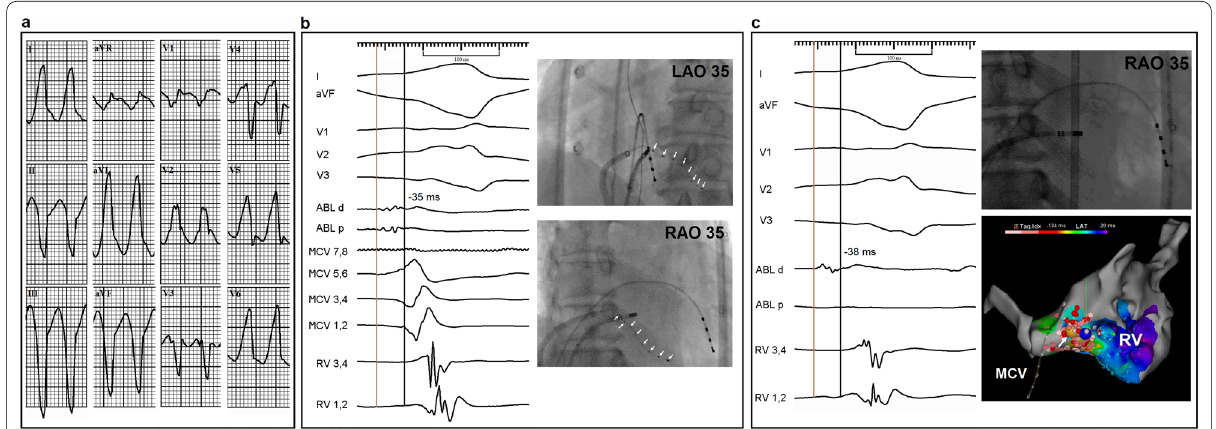
Fig. 2 a A 12‑lead ECG of clinical VT. b Left panel : intracardiac EGM at the ablation site within the proximal of MCV. Right panel : ablation catheter positioning during the ablation within the proximal of MCV (small white arrows show the microcatheter positioned in MCV). c Left panel : intracardiac EGM at the successful ablation site showed the earliest ventricular activity of 38 ms preQRS. Right panel : ablation catheter positioning and electro‑anatomical mapping showed the successful ablation site (white arrow) at the basal inferior ventricular septum. MCV indicates middle cardiac